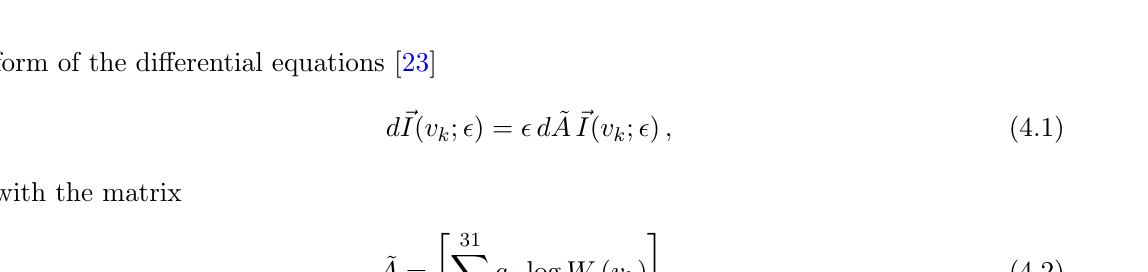
Figure 5 . Genuine (cid:12)ve-particle